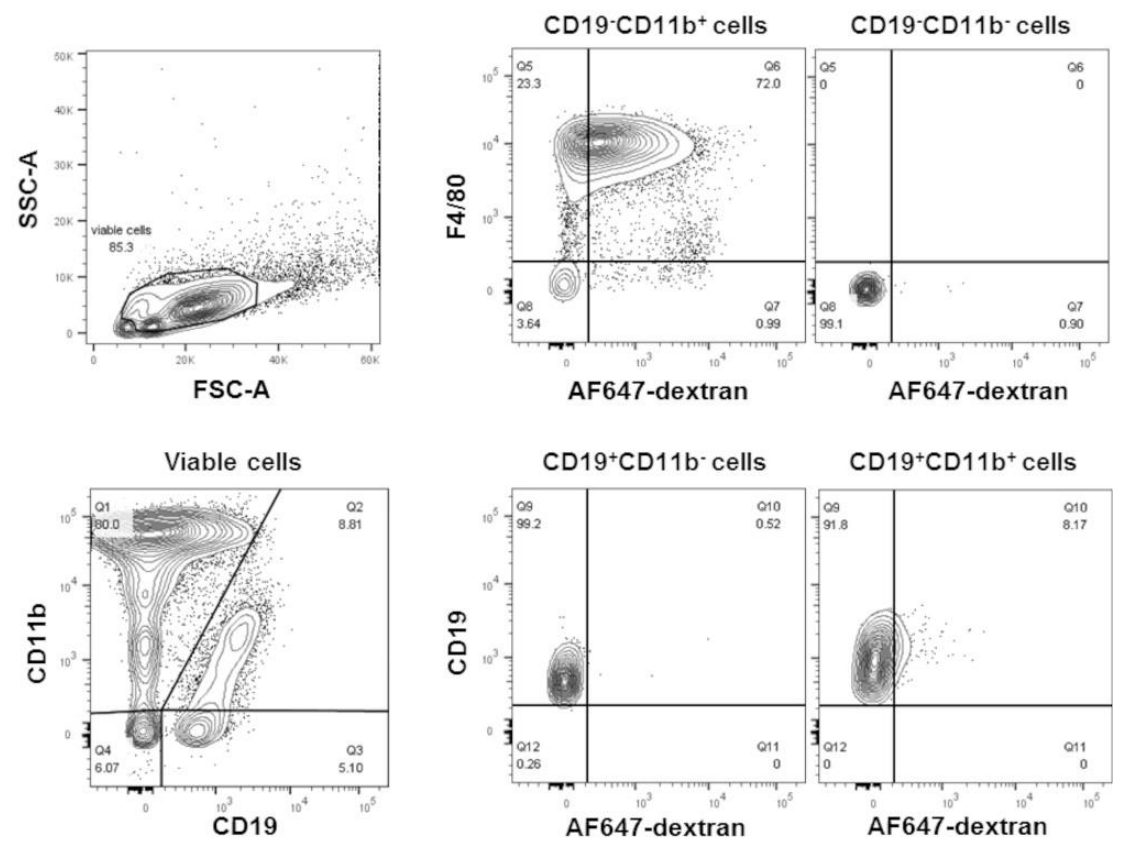
Figure 1. POPC liposomes are readily captured by peritoneal macrophages. POPC liposomes (400 µ g) loaded with AlexaFluor647-labeled dextran were injected (1 mL in PBS) into the peritoneal cavity of CD-1 mice. After 1 h, peritoneal cells were collected by lavage, centrifuged, counted, and resuspended in FACS staining buffer. After blocking Fc receptors with anti-Fc γ R antibodies, peritoneal cells were incubated with FITC-conjugated anti-F4/80, PE-conjugated anti-CD11b, and PerCP-conjugated anti-CD19. Propidium iodide was also used to determine cell viability. Flow cytometry was performed using a FACSCanto II flow cytometer with FACSDiva software. The data were analyzed using FlowJo software. Peritoneal macrophages are defined as CD19 − CD11b + F4/80 + ; B cells are defined as CD19 + CD11b − , and B1 cells are defined as CD19 + CD11b +